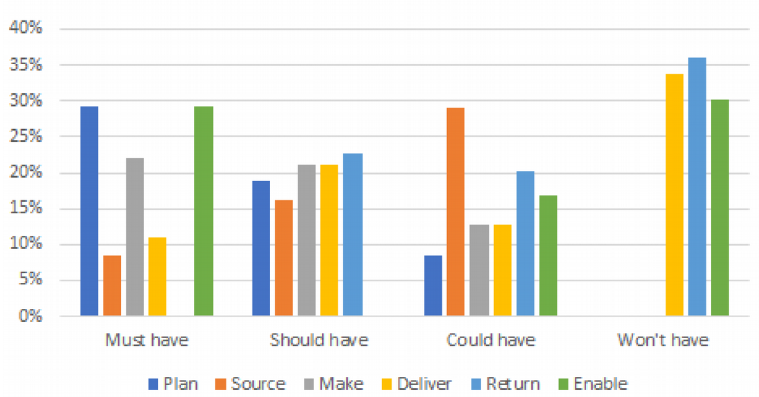
Figure 7. Analysis of prioritised metrics by